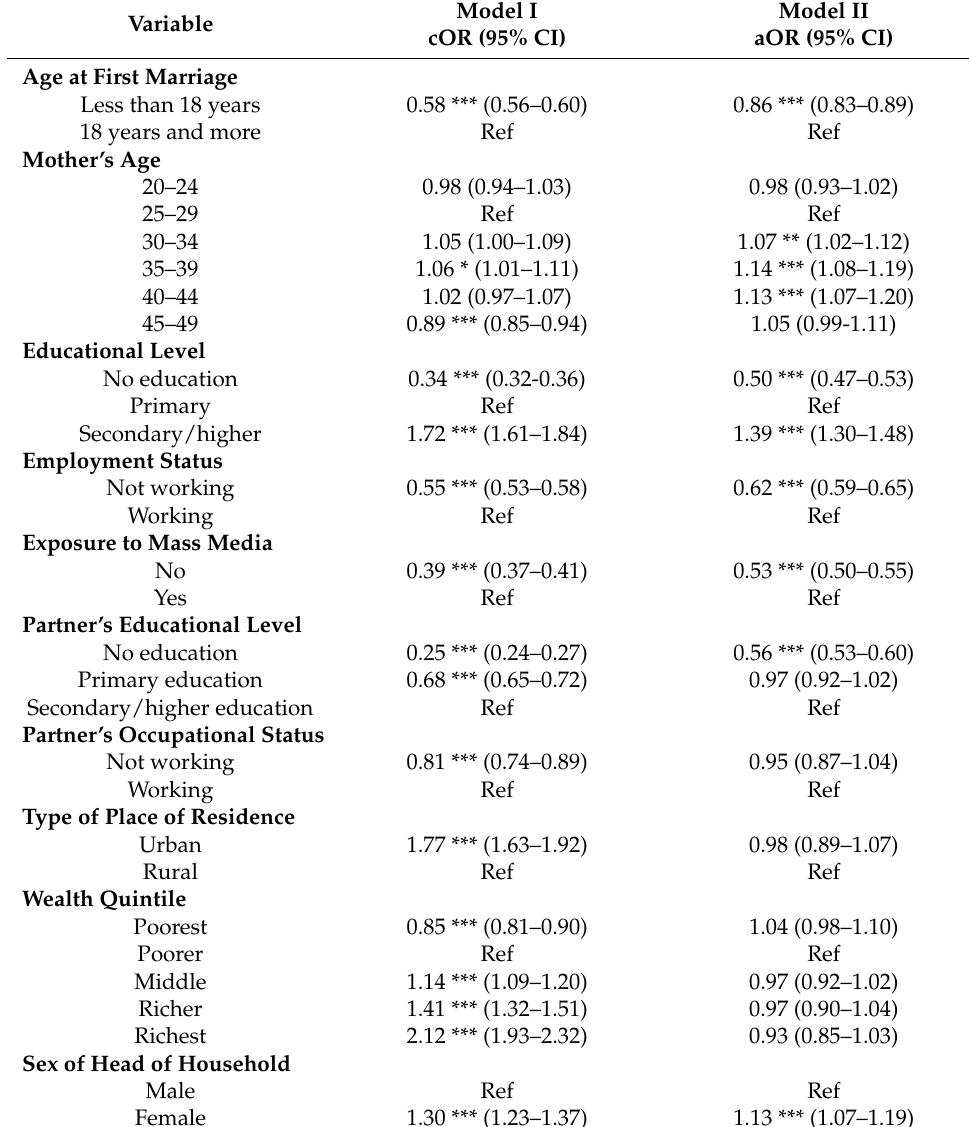
Table 3. Binary logistic regression results on the predictors of sexual autonomy among women in sub-Saharan